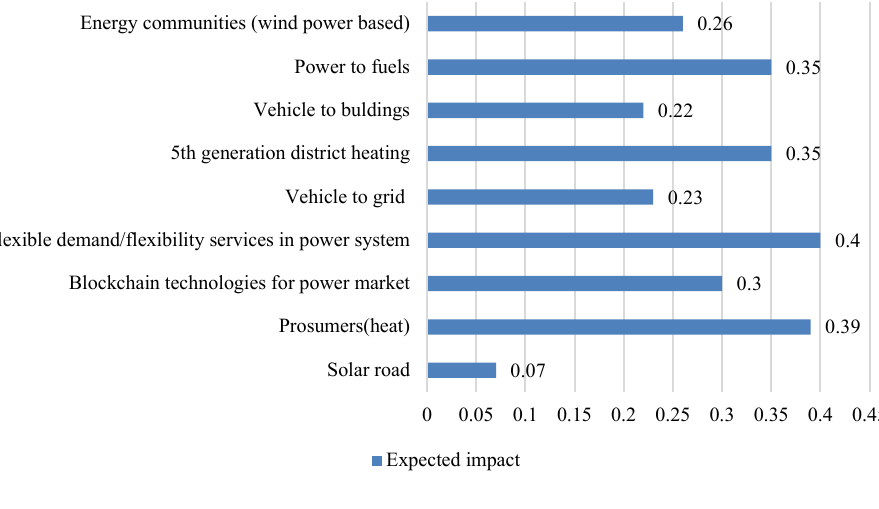
Fig. 3. Expected Impact on scale 0–1 of business models with lowest score in category. Fig. 4 evaluates four business models with the highest expected impact of all technologies.